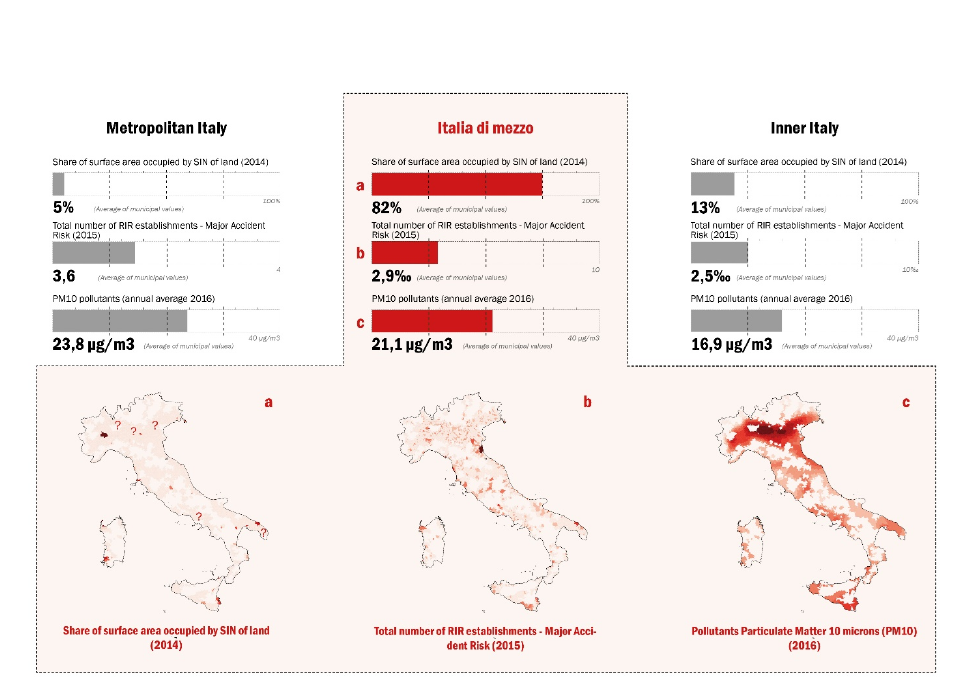
Figure 6: Italia di mezzo with strong environmental problems, sometimes higher than metropolitan